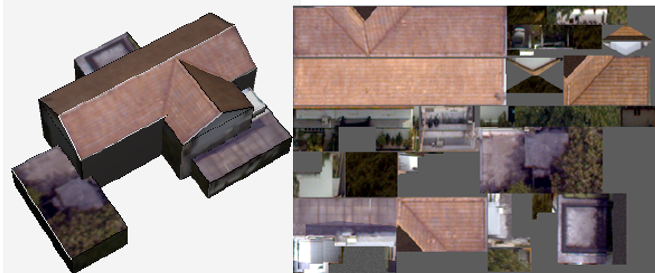
Figure 2. UV space of a building model. In UV space, each vertex v i of the geometry has a corresponding texture coordinate t i . The UV space simplifies matching faces, since texture coordinates remain unchanged or are re-sampled during deformation, push-pull, and template